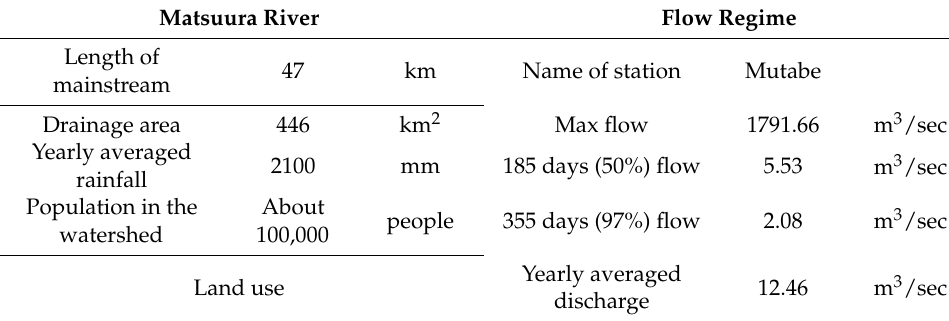
Table 1. Matsuura River’s elements and flow regime